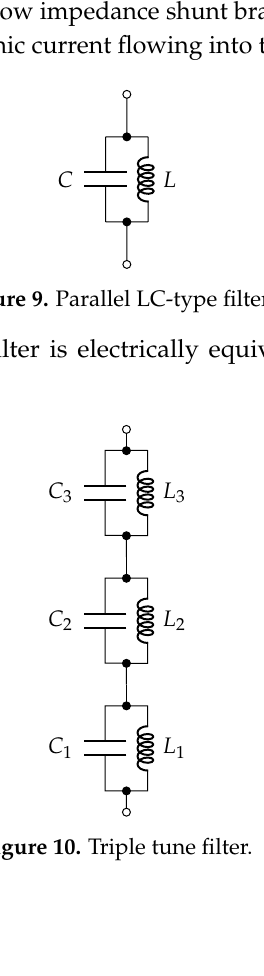
Figure 8. Series LC-type filter.